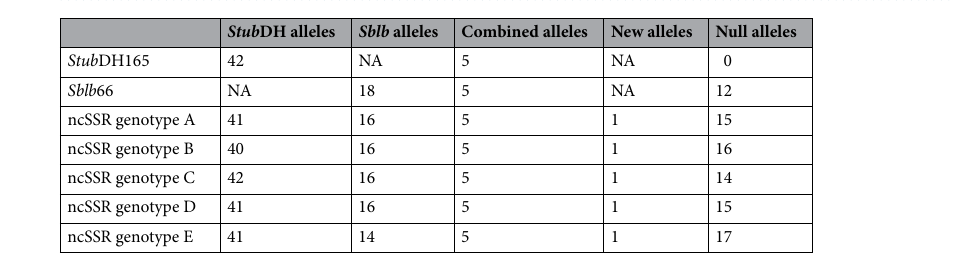
Table 2. Incidence of Stub DH-specific, Sblb -specific, combined, new and null alleles of ncSSR markers in parents and in groups of somatic hybrids classified according the specific ncSSR genotype (A–E).